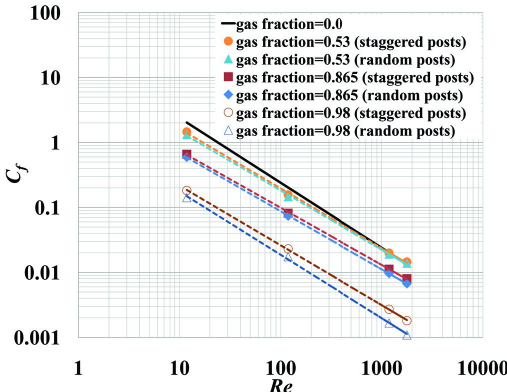
Figure 24. Skin-friction coefficient versus Reynolds number (Moody diagram) for different gas fractions. From Samaha et al. [79].